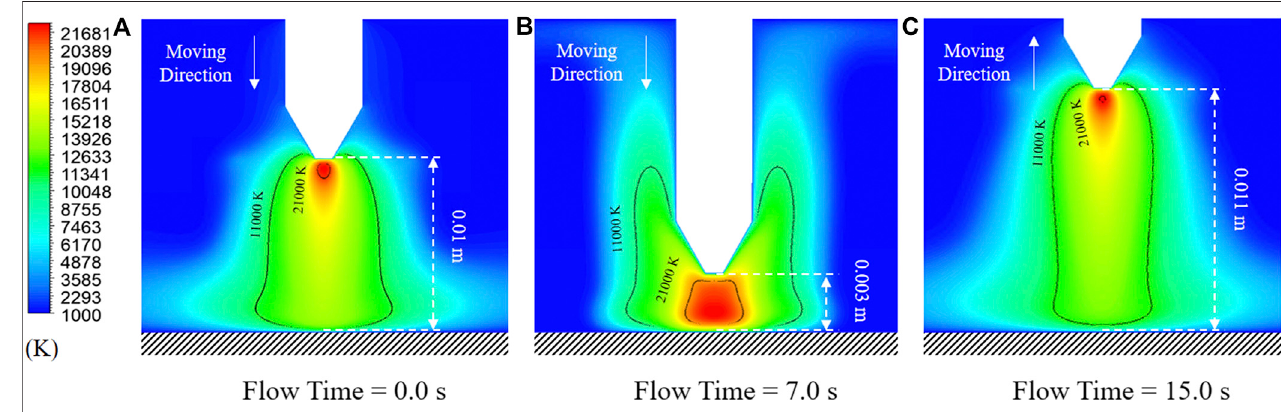
FIGURE 6 | Dynamic effect of varying arc length due to electrode movement on the arc characteristics. (A) Flow time (cid:2) 0.0 s, (B) fl ow time (cid:2) 7.0 s, (C) fl ow time (cid:2) 15 0 s.